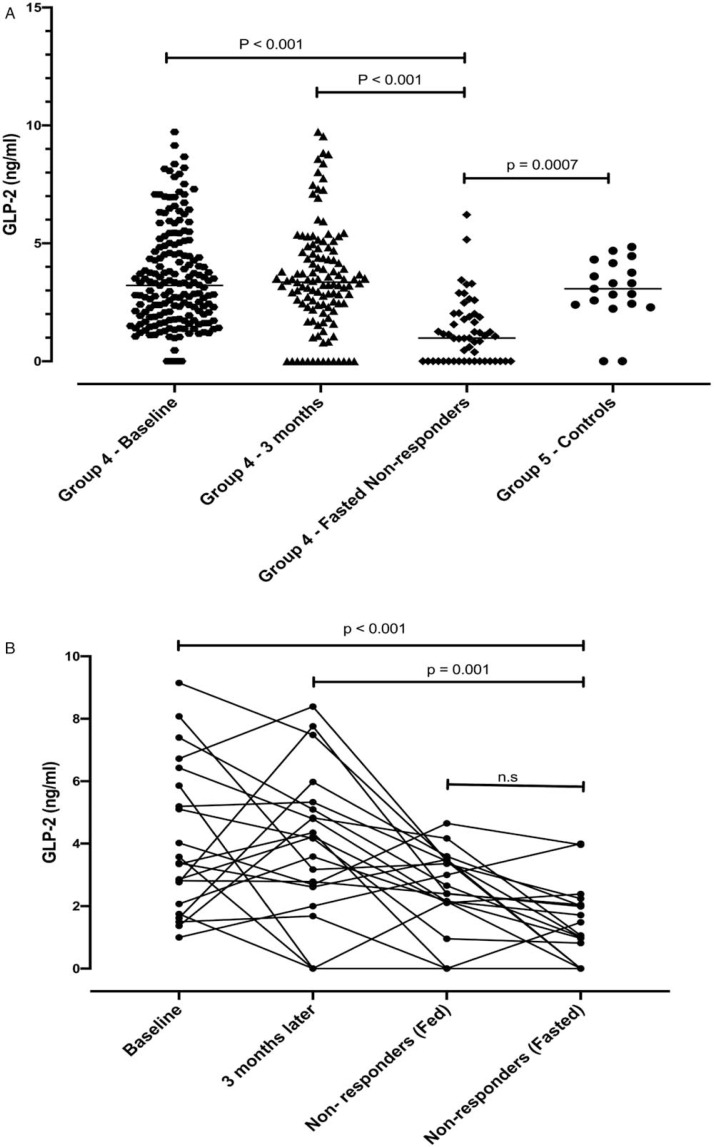
A, GLP-2 levels in stunted children at baseline, 3 months and before endoscopy (fasted nonresponders) compared to healthy controls from the same community. B, Repeated GLP-2 measurements in children designated nonresponders at baseline, 3 months, and in the fed and fasted state. Children were fed ad libitum. GLP-2 = Glucagon-like peptide 2.